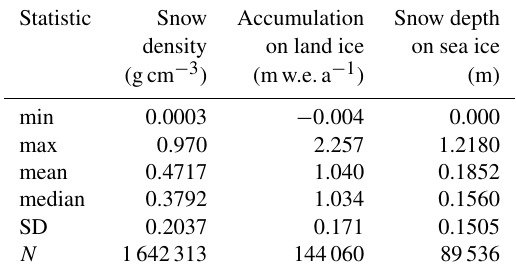
Table 4. The descriptive statistics for all of the Arctic measure- ments in SUMup, including the minimum (min), maximum (max), mean, median, standard deviation (SD), and number of measure- ments ( N ).